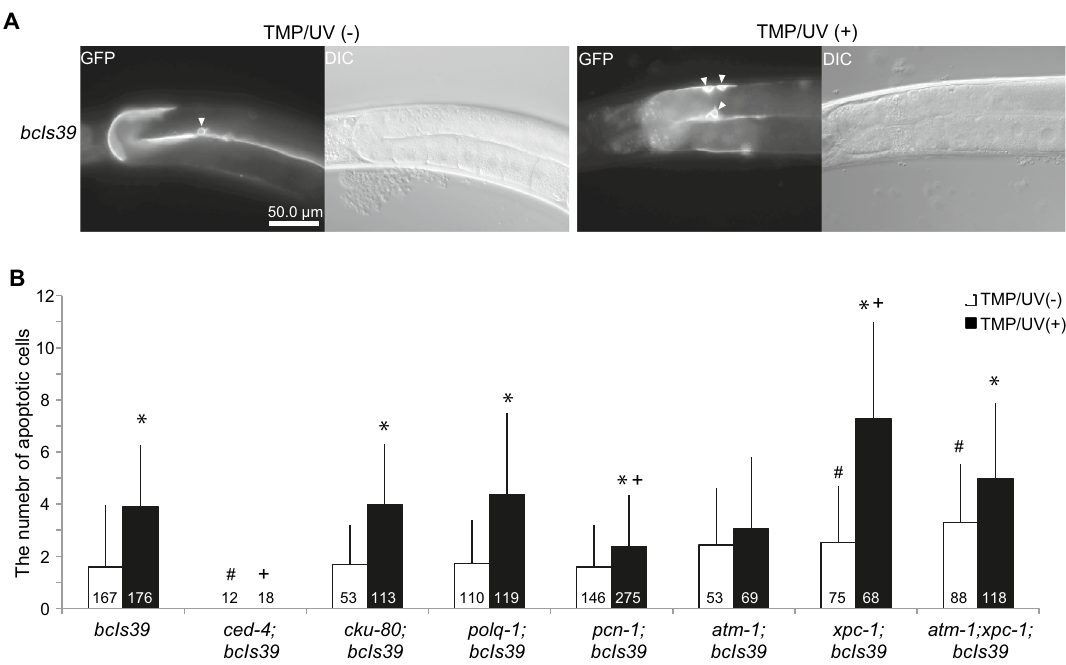
Figure 2. Germ cell apoptosis in the TMP/UV treated DDR mutants. ( A ) Representative images of intact and TMP/UV treated bcls39 [CED-1::GFP] . White arrowheads indicate apoptotic cells. ( B ) The averaged numbers of apoptotic germ cells two hours after TMP/UV mutagenesis were shown as a bar graph. The white bars demonstrate the non-treated worms and the black bars indicate the result of TMP/UV treated worms. The error bars demonstrate the SD. All the data were tested by Steel Dwass’s Test using R software 56 . *p < 0.05, differences between TMP/UV(–) and TMP/UV(+) of each strain, #p < 0.05, differences between TMP/UV(−) mutants and TMP/UV(−) wild-type, + p < 0.05, difference between TMP/UV(+) mutant and TMP/UV(+) wild-type. The p-values between other pairs are summarized in Supplementary Table S3. The numbers of observed gonads are displayed on each